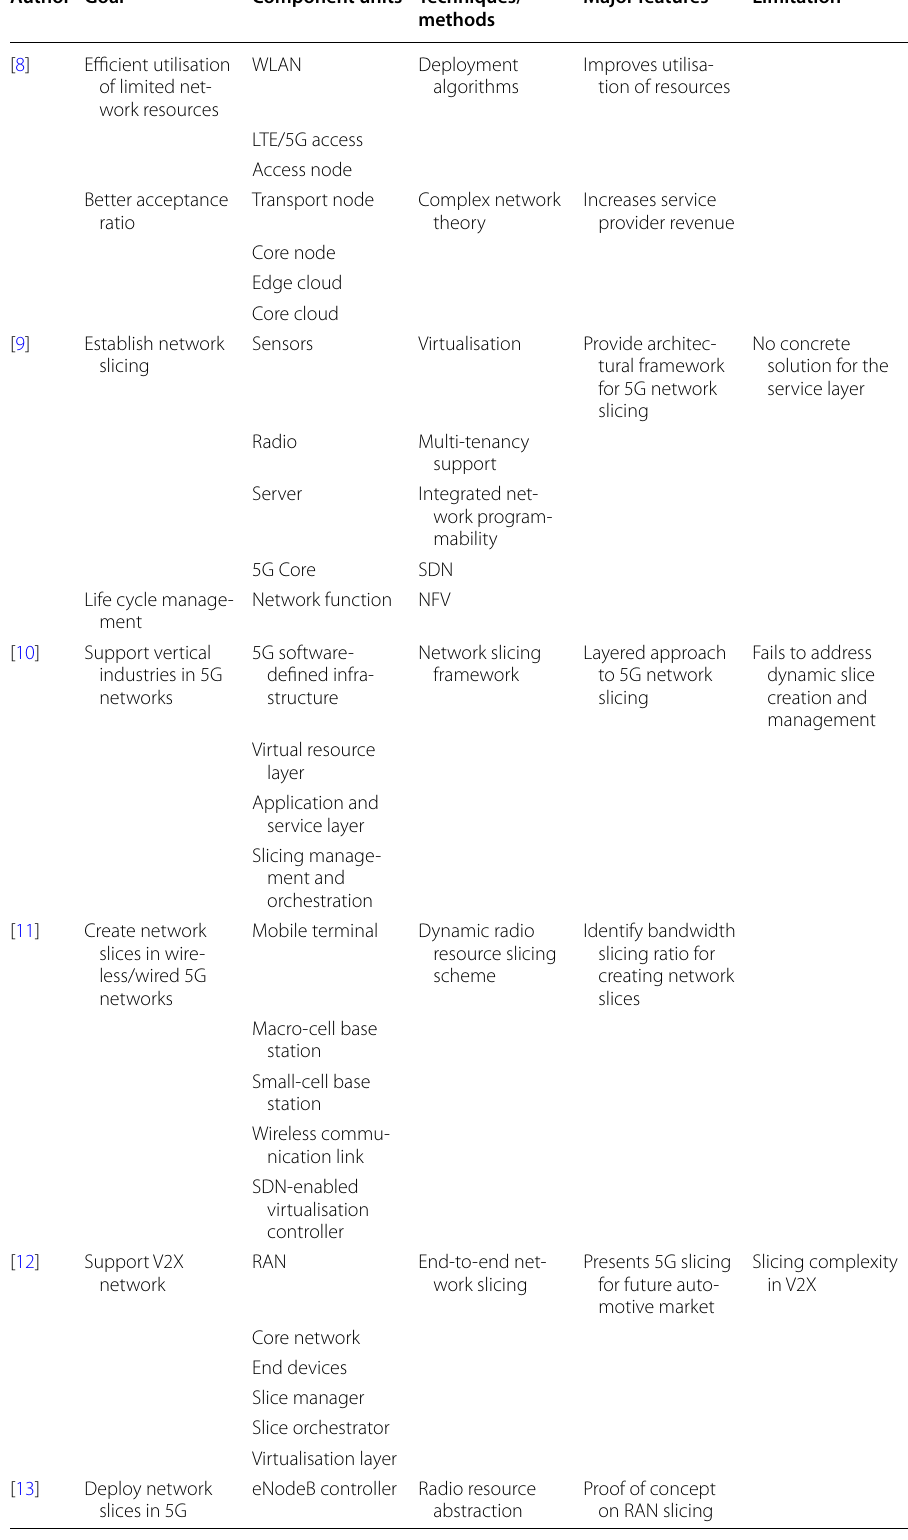
Table 4 Validation of publications using different factors Author